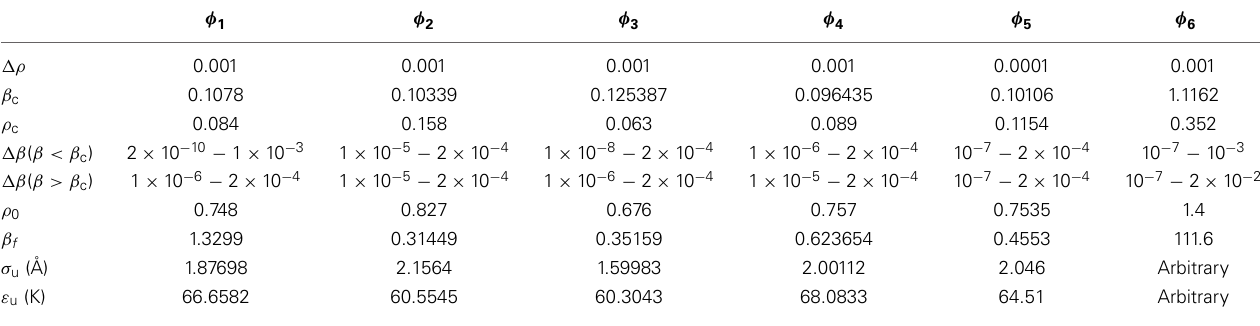
Table 2 | Parameters used in numerical computations for Models